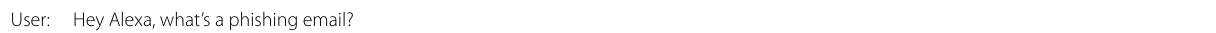
Table 1 Interaction-based phishing awareness training